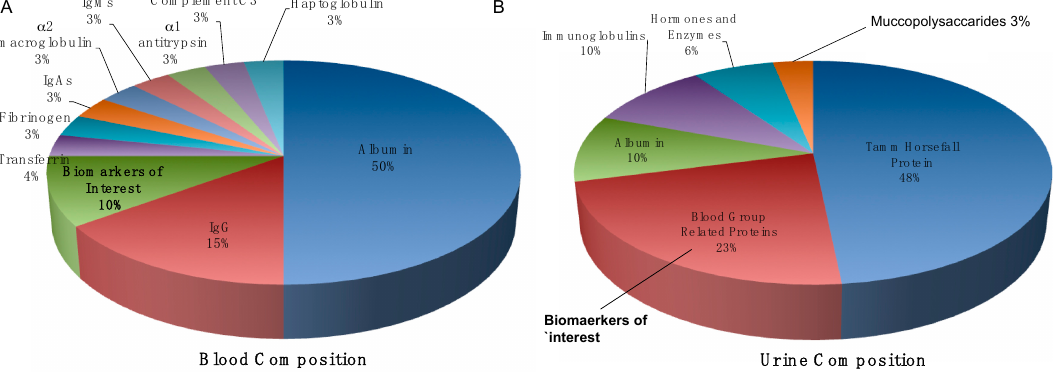
Figure 3. Dynamic range of protein concentrations in biological fluids: Figure 3 gives a breakdown of the concentration of proteins found in blood ( A ) and urine ( B ) samples. Notably, blood proteins, which are considered to be significant to biomarker discovery studies, make up less than 10% of the total concentration of blood proteins [167,170].